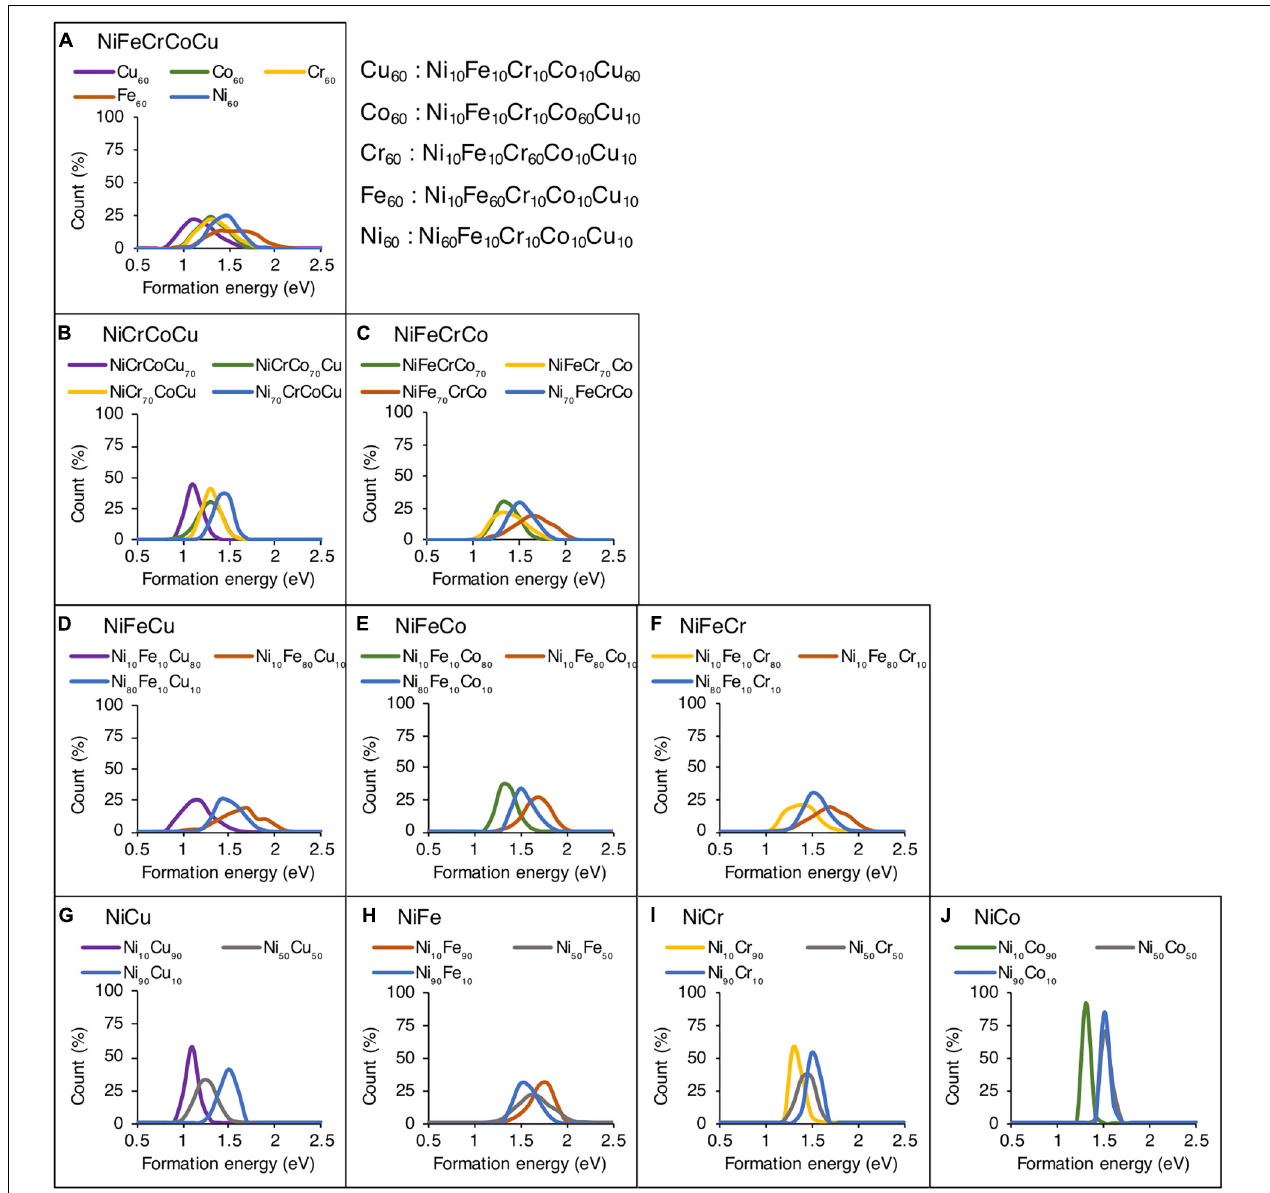
FIGURE 4 | Effect of alloying elemental concentration on vacancy formation energies in (A) quinary, (B,C) quaternary, (D–F) ternary, and (G–J) binary alloys. Only the results of Ni-based alloys are